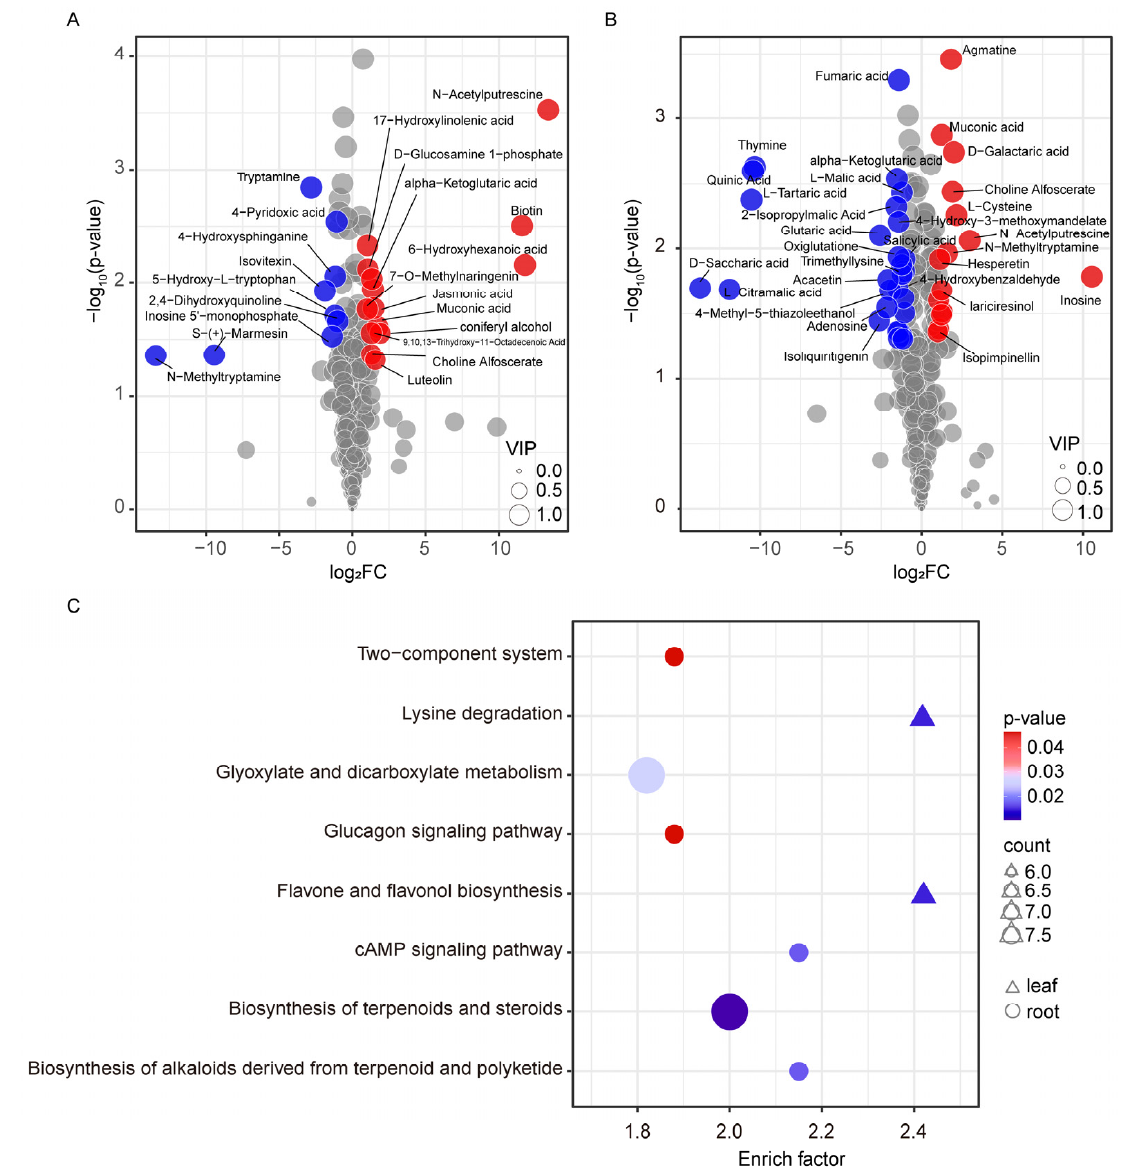
Figure 6. Differentially accumulated metabolites (DAMs) with KEGG pathway information and the enriched pathways of these DAMs. ( A ): DAMs in the leaves after CLas infection; ( B ): DAMs in the roots. The metabolites whose change did not meet the differentially accumulation threshold were filled with gray color in A and B. The upregulated and the downregulated ones were colored in red and blue, respectively. The cycle size indicated the VIP value in the OPLS-DA analysis; ( C ): Pathway enrichment analysis of the DAMs using the KEGG annotation background information detecting in the clusterProfiler software [36]. Only pathways with p -value < 0.05 in the Fisher’s exact test were plotted.